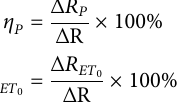
TABLE 1 Hydrological sequence evolution of KRB. Hydrological